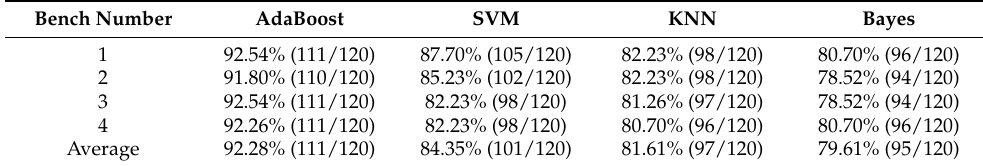
Table 8. Accuracies of different classifiers without LSTM interval recognition.